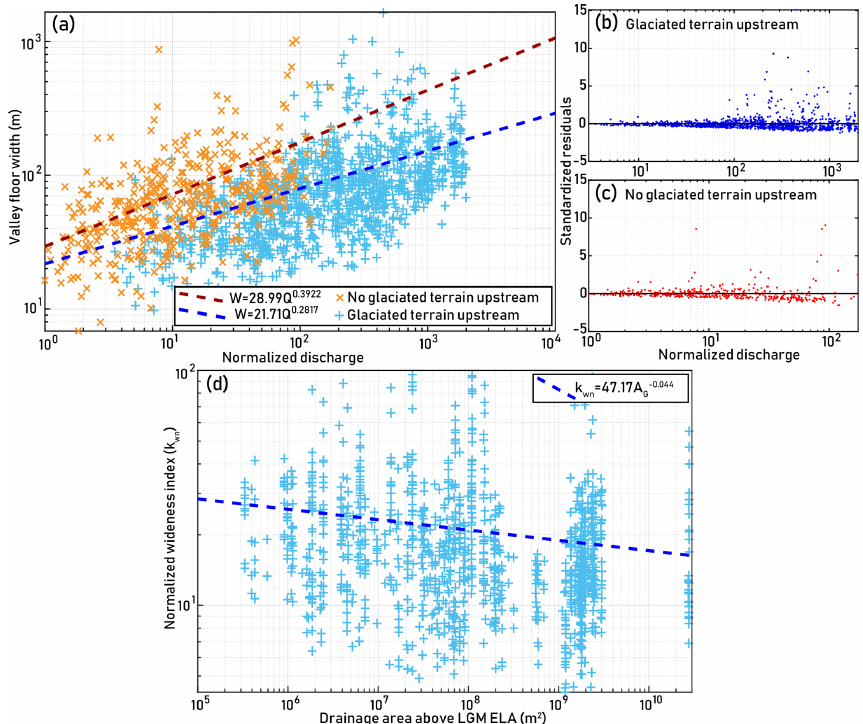
Figure 5. (a) Valley floor width versus discharge for rivers with and without headwaters above the LGM ELA, with power law fits for valley wideness. Locations of valley width measurements are shown in Supplement Fig. 1. (b–c) Residuals plots for power law fits shown in (a) . (d) Normalized wideness ( k wn ) versus contributing drainage area above the LGM ELA for valley width measurements in blue from (a) . Here, A G refers to drainage area above the ELA. Spearman’s ρ = − 0 . 2116 with P < 0 . 0001. We conducted a two-sample Kolmogorov–Smirnov test for the distributions of k wn ratios with above-ELA drainage areas between 10 7 –10 8 m 2 ( n = 332) and 10 9 –10 10 m 2 ( n = 378) and found that the empirical CDF for the latter group is larger with P < 0 . 0001. Fits shown here were calculated using the “nlinfit” function in